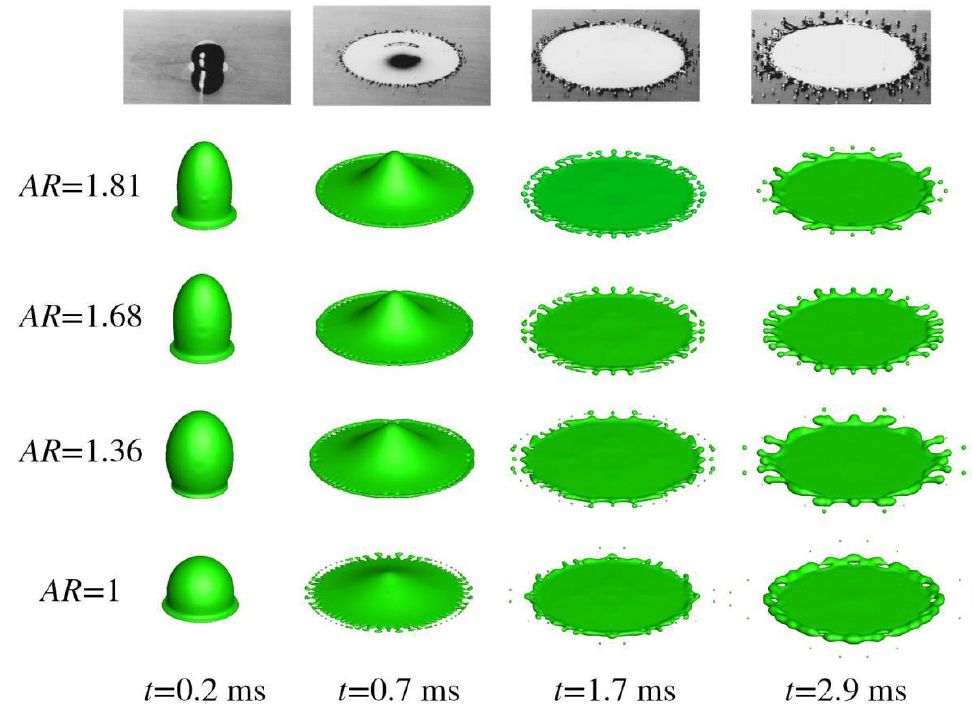
Figure 17. Prolate Tin droplet impingement with an 90° impacting angle.